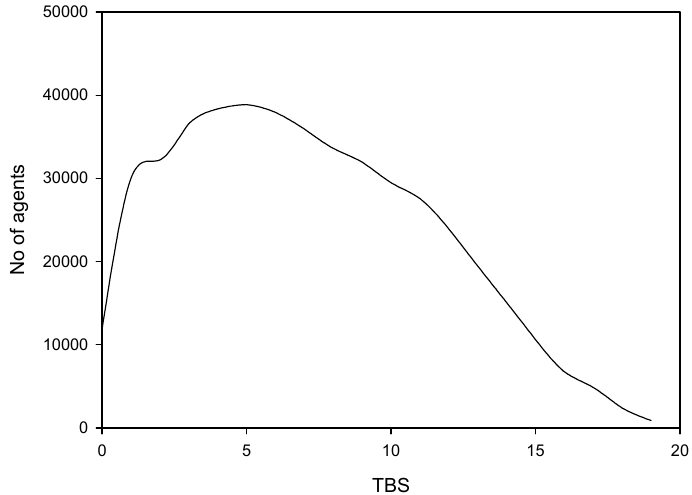
<Figure 4.2> TBS distribution for social